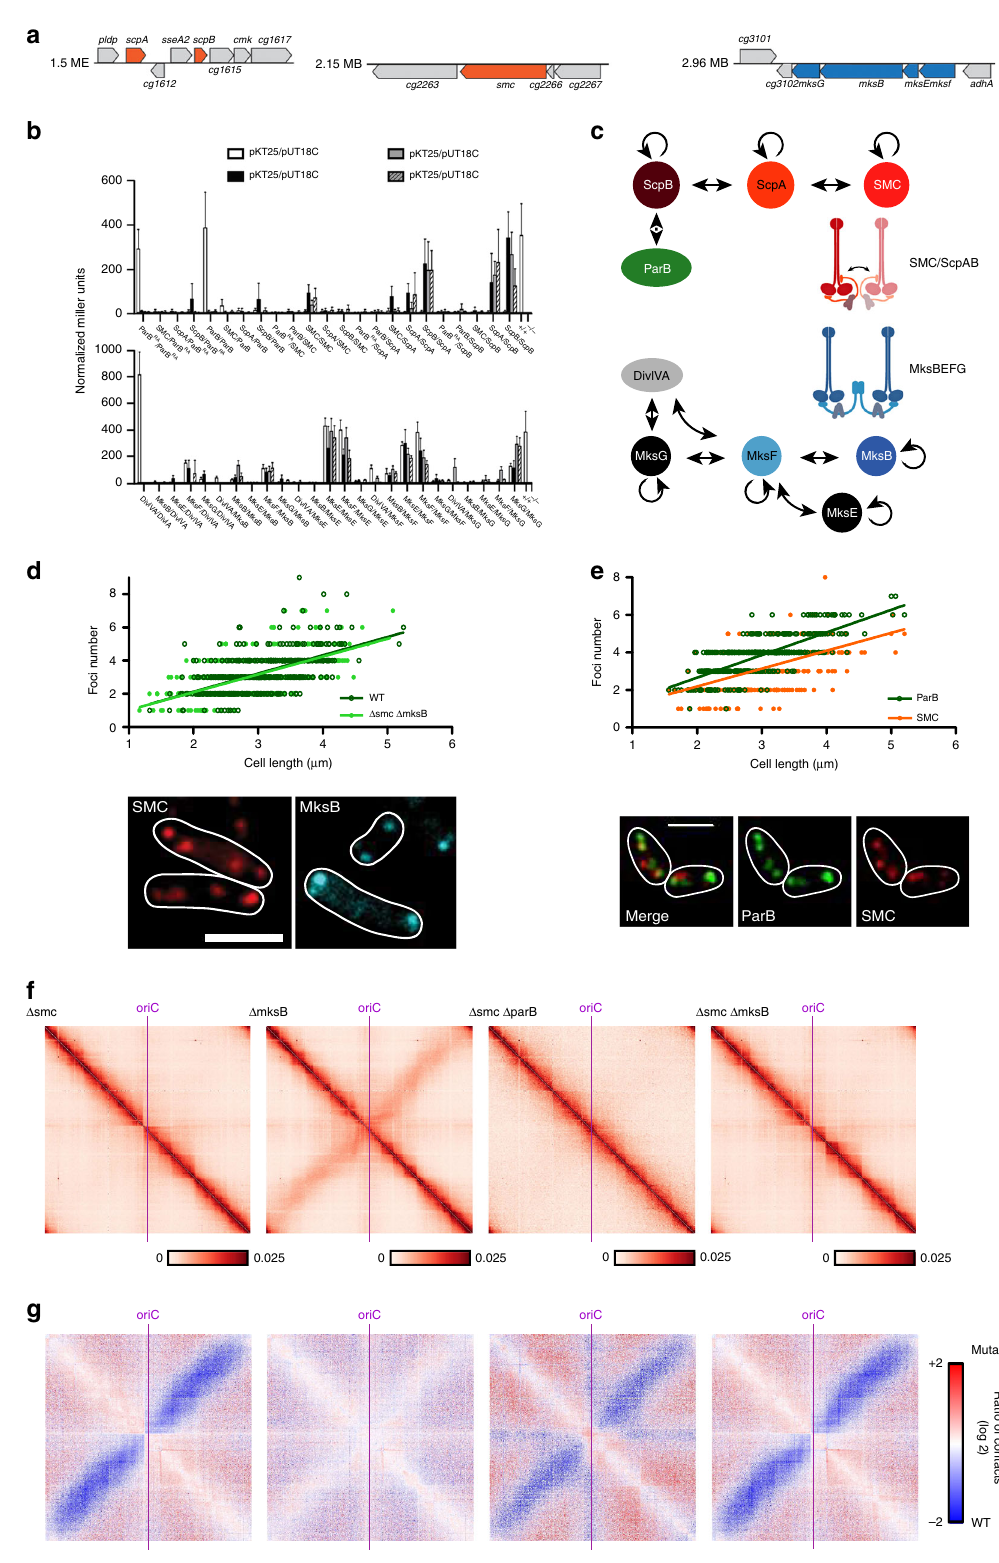
reinsertion at another genomic position (Supplementary Fig. 10D-F) or following its substitution by a random DNA sequence (Supplementary Fig. 10D, G). Therefore, the accumu- lation of SMC at the 13 Kb region in the vicinity of parS sites points at roadblocks that trap SMC rather than speci fi c SMC binding. This hypothesis is further supported by the study of